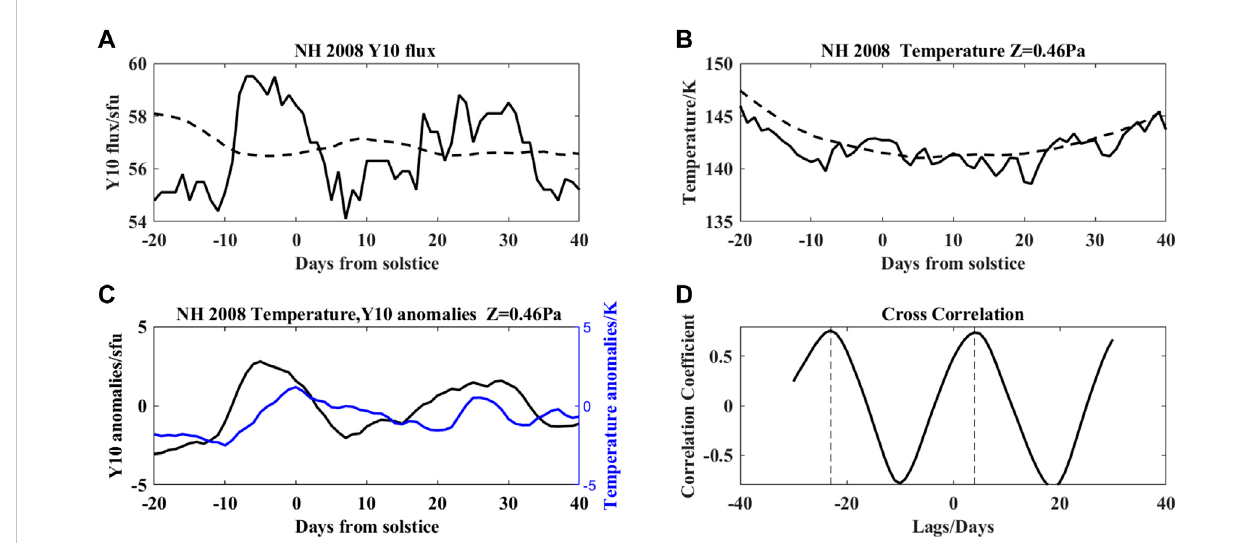
FIGURE 1 (A) SolarradiationindexY10(solidline)andits35-dayrunningmean(dottedline)duringtheNHPMCseason in2008. (B) Averagetemperature(solid line) and its 35-day running mean (dotted line) in the latitude range of ~60 ° – 80 ° at 0.46 Pa atmospheric pressure during the 2008 NH PMC season. (C) Y10 anomaly (black line) and temperature anomaly (blue line) to relative summer solstice days. (D) Correlation coef fi cient between Y10 anomaly and temperature anomaly at different time